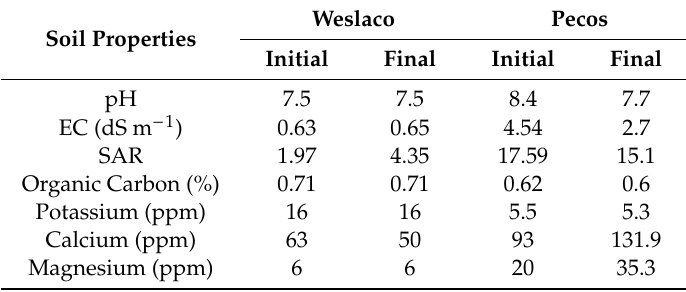
Table 6. Soil properties for the experimental areas in Weslaco and Pecos at the beginning and end of the duration of the